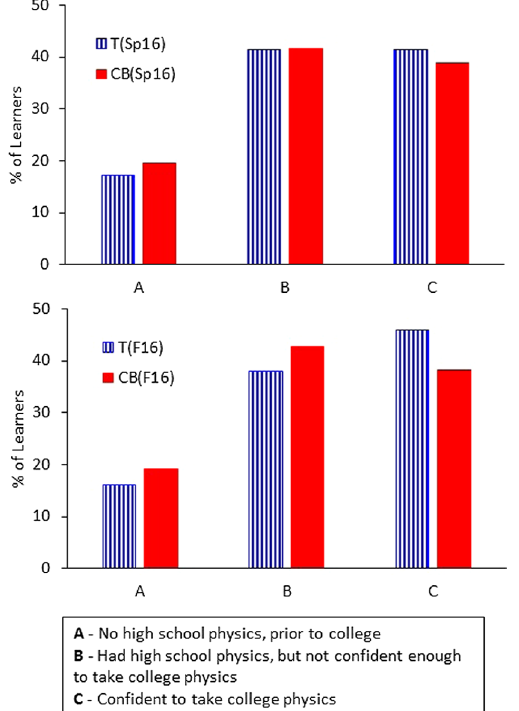
FIG. 2. A background evaluation of the two classes (Tand CB) at thebeginningofthespring(top)andfall(bottom)semestersin2016. The height of the vertical bars indicate the % learner population that chose one of the categories listed along the horizontal axis. The striped columns represent the T class and the solid columns represent the CB class. Both classes were similarly populated by learners in terms of their prior to college physics experience and self efficacy towards the college physics learning experience.